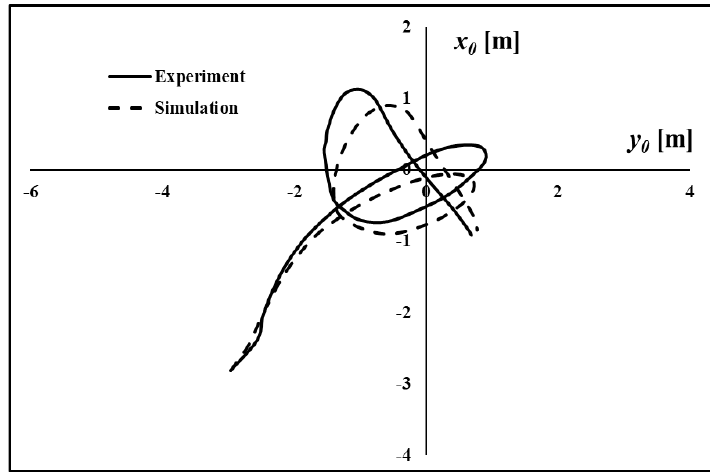
Figure 24. Comparison of experiment and simulation at P10.